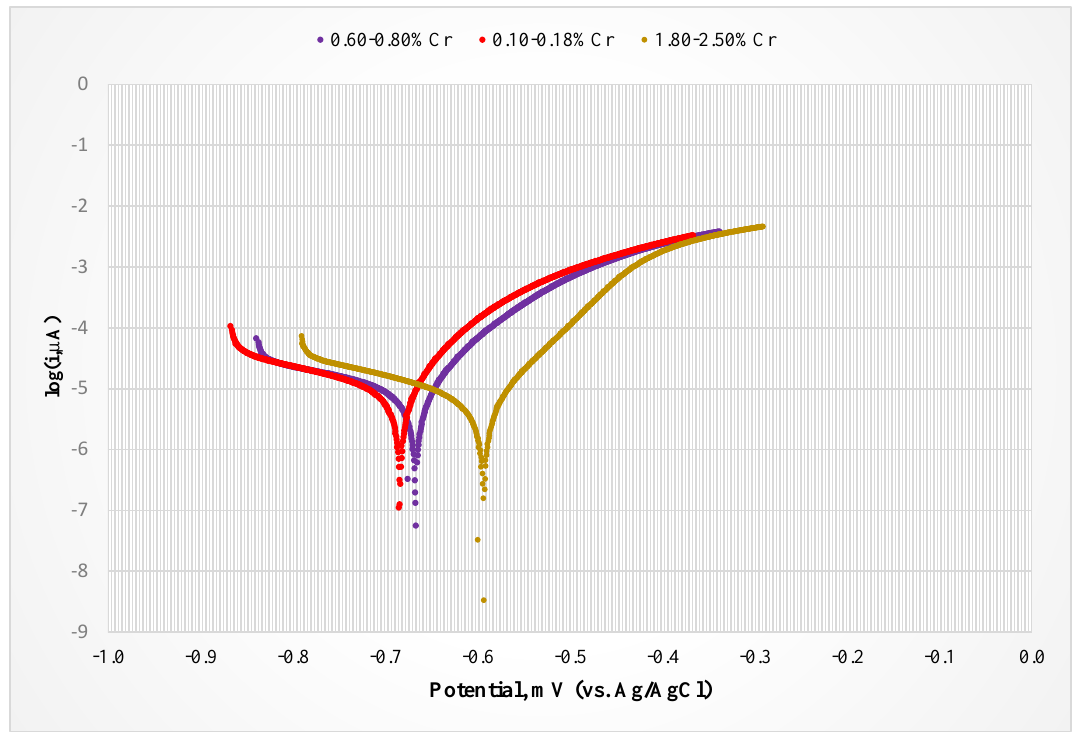
Figure 5. The cathodic and anodic (Tafel) polarisation curves for dual-phase high carbon steels with different Cr content in 0.1 M NaCl solution.